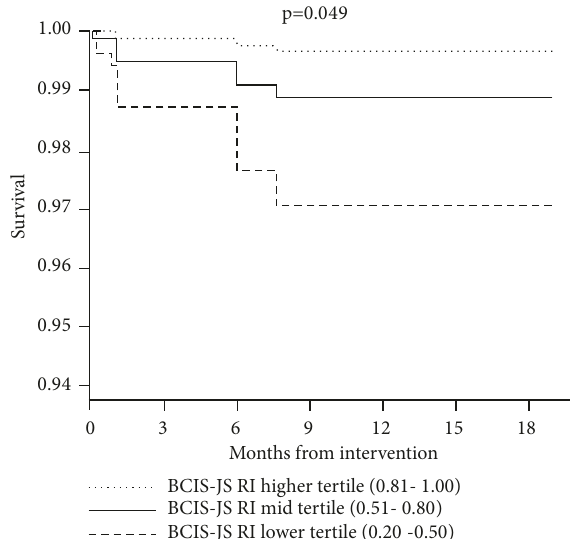
Figure 4: Survival curves according to revascularization extent . The figure shows the adjusted survival curves in the study population stratified according to British Cardiovascular Intervention Society JeopardyScore(BCIS-JS)revascularizationindextertiles.RI=revas- cularization